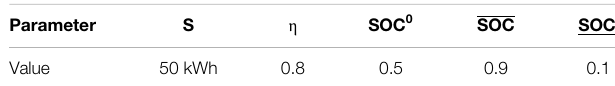
TABLE 4 | Battery storage parameters.